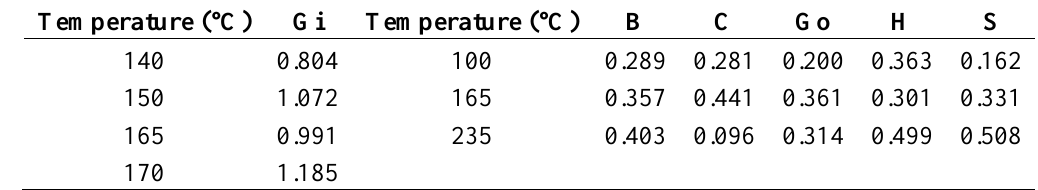
Table 4. Reaction orders ( n ) derived from Sharp-Hancock lines of best fit (ln(−ln(1 − α)) vs. ln( t )) to mineral transformations in bauxite residue. Mineral names are abbreviated as